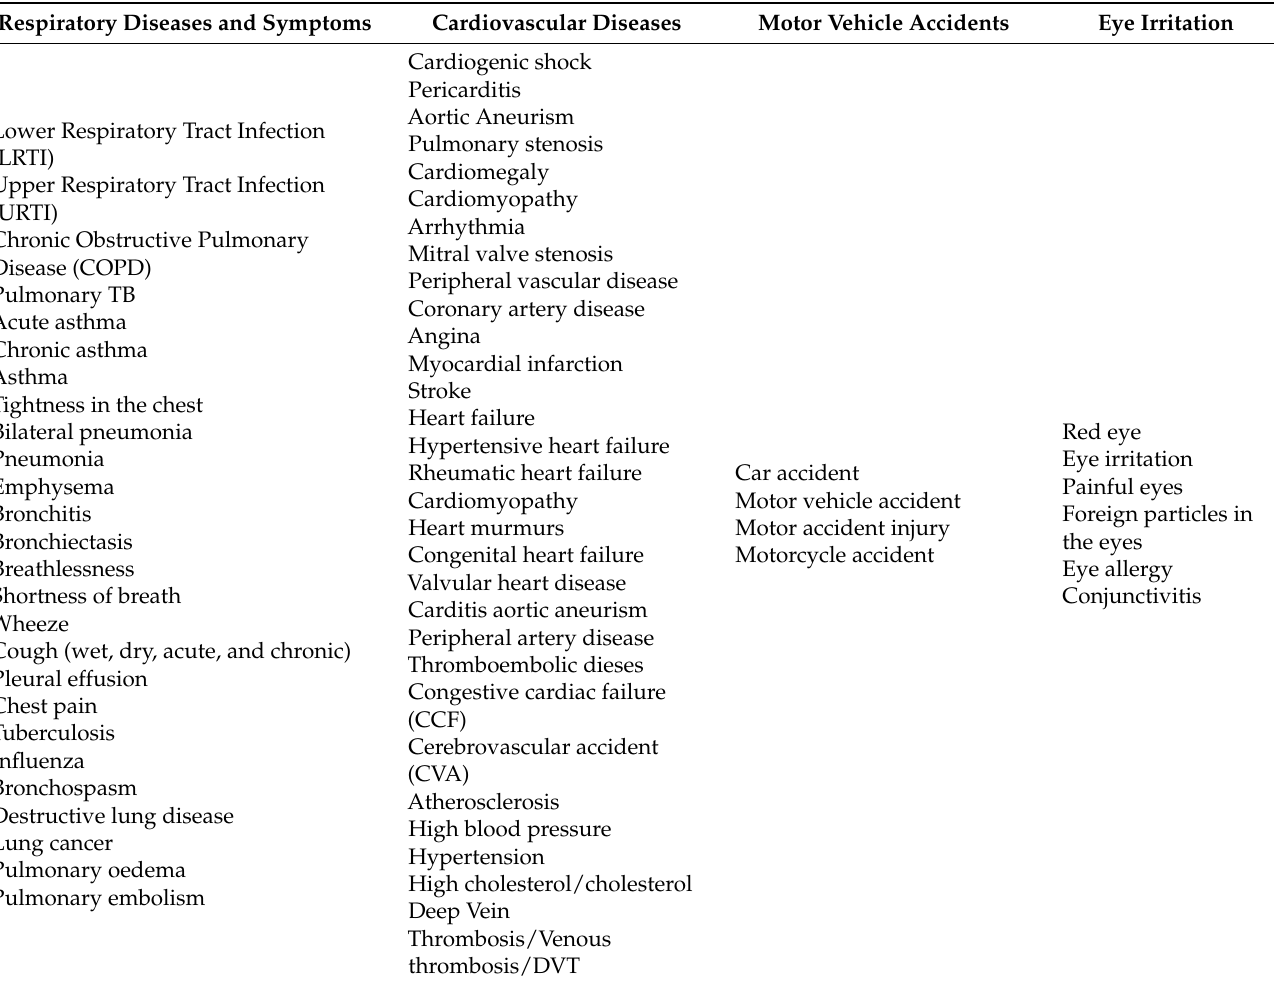
Table A1. Terms used for each of the health outcomes of interest in the